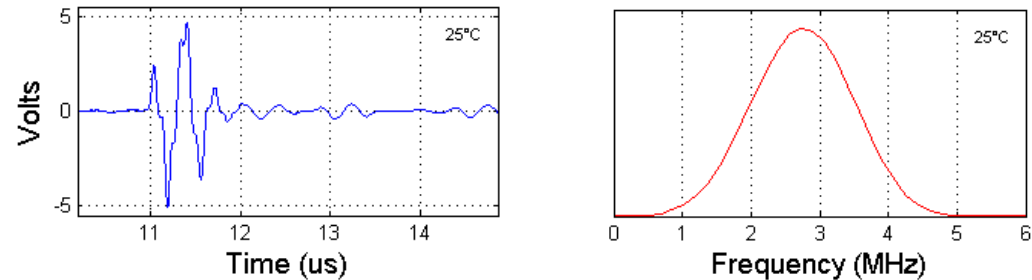
Figure 7. Time and frequency domain signal from backwall echo of steel test block for LiNbO 3 brazed with AgCu (room temperature test).